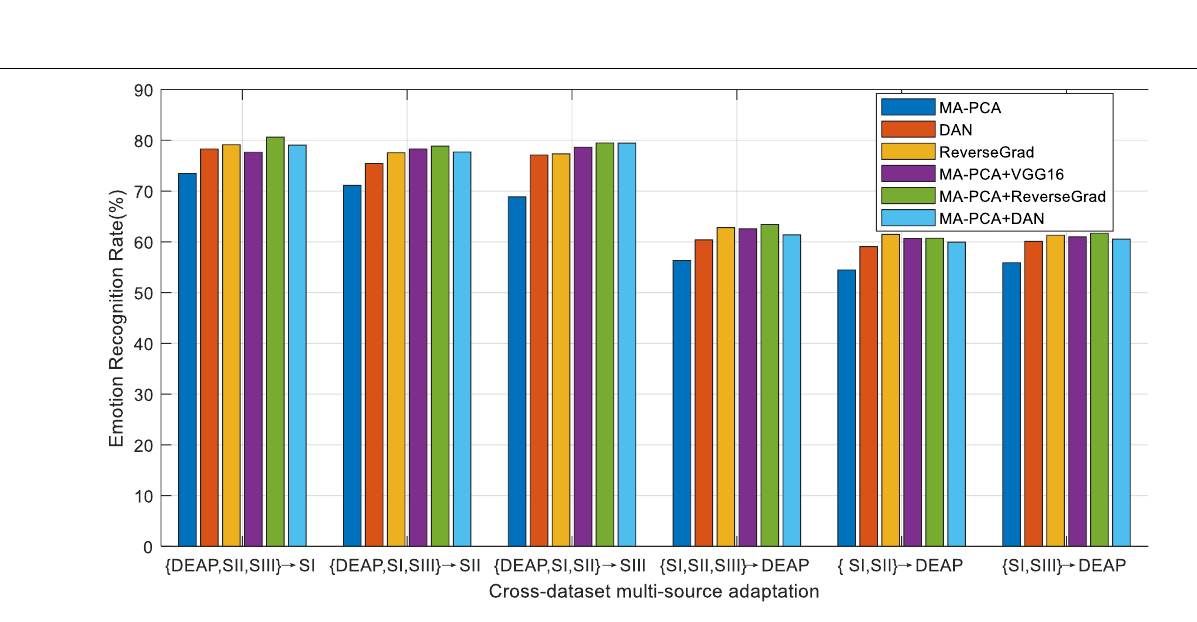
FIGURE 5 | Adaptive emotion recognition using deeply extracted